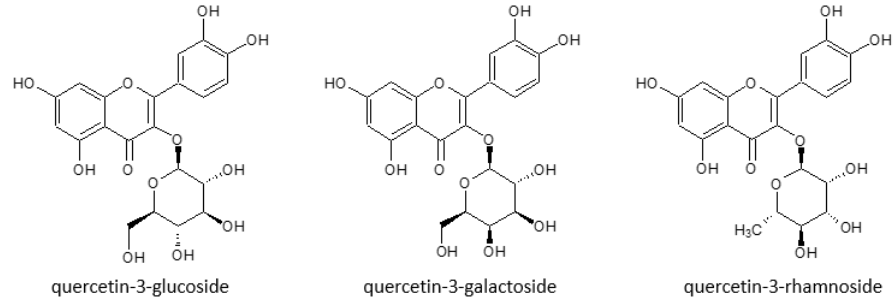
Figure 6. Chemical structures of quercetin derivatives.